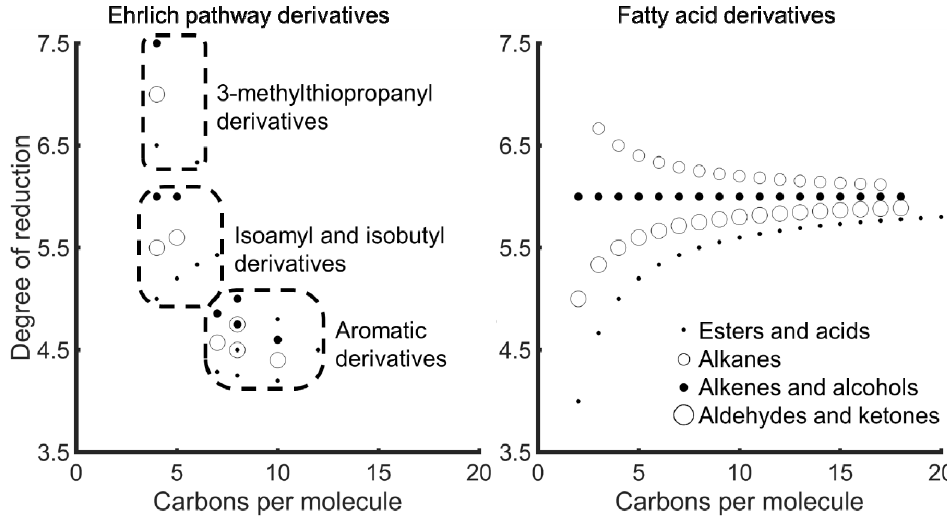
Figure 6. Degree of reduction of functionalized hydrocarbons plotted versus required carbons per molecule.